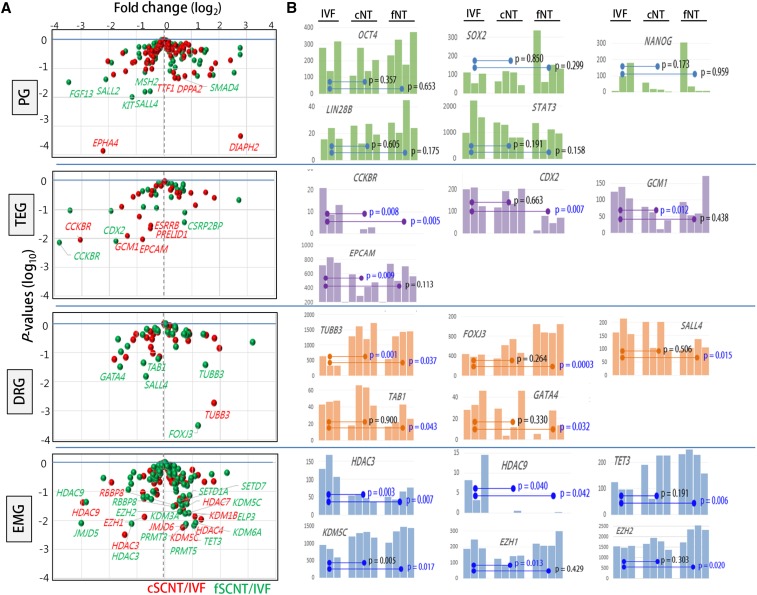
Differential expressions of developmentally important genes between in vitro fertilization (IVF) and somatic cell nuclear transfer (SCNT) blastocysts. (A) Volcano plots of relative expression of each category of genes in cSCNT (red) and fSCNT (green) over IVF mean. Differentially expressed genes (DEGs) with P-values of <0.05 are labeled with gene symbols. PG, 100 pluripotency-related genes; TEG, 27 trophectoderm development-involved genes; DRGs, 51 developmental regulators; EMGs, 89 epigenetic modifiers. (B) DEGs between IVF and either cSCNT or fSCNT blastocysts. Statistical differences between the blastocyst groups are indicated by p-values (t-test).